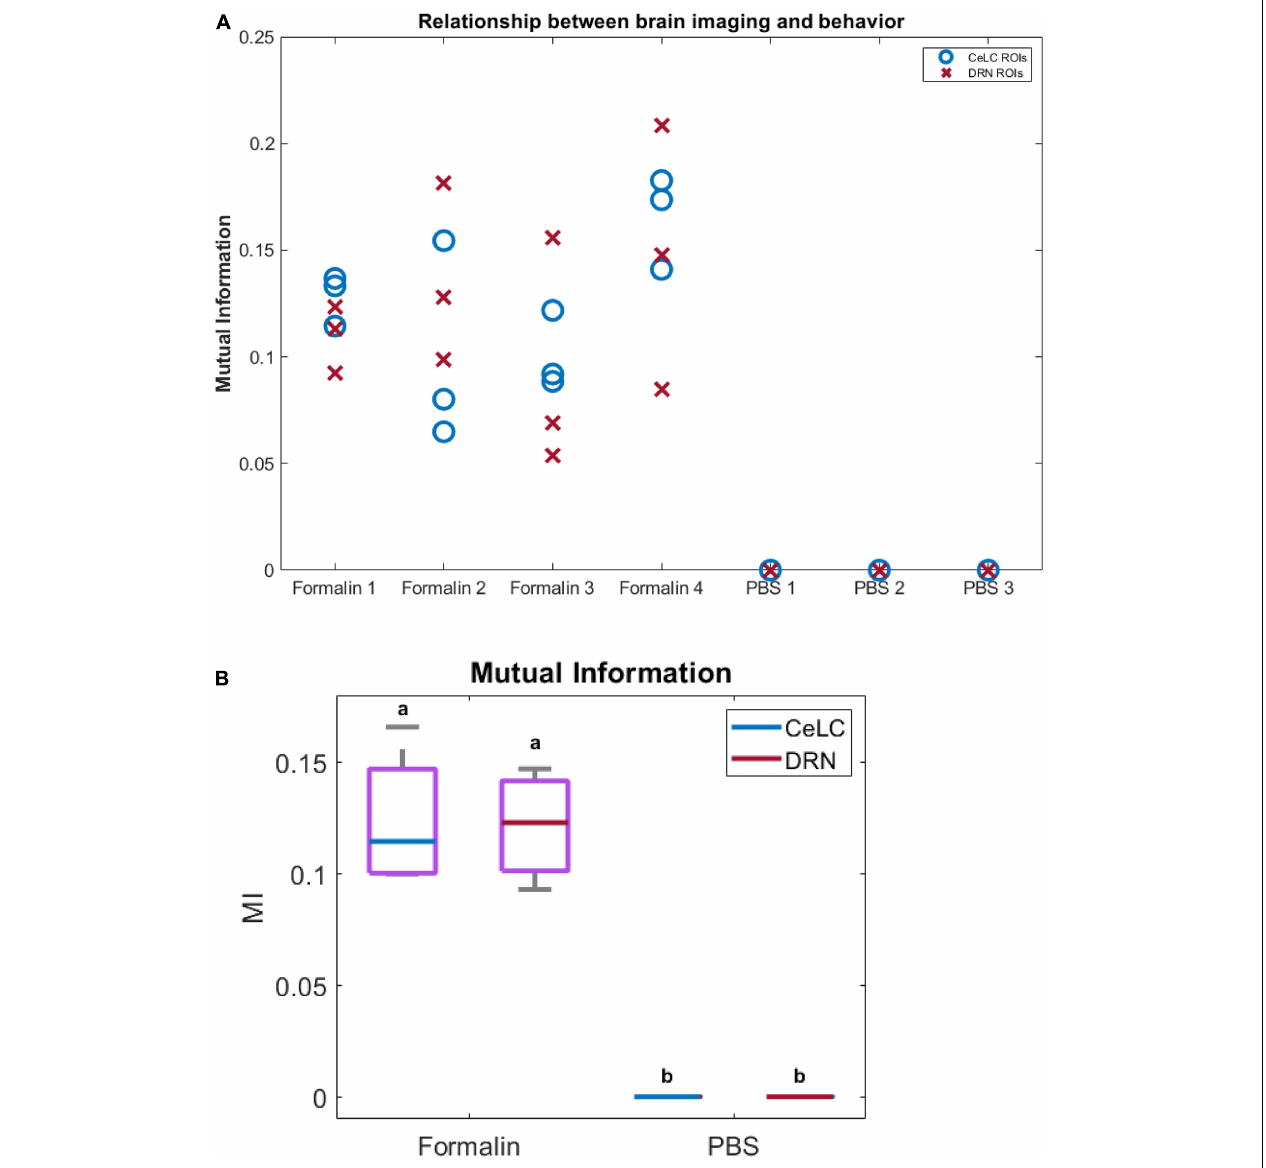
FIGURE 10 | Relationship between brain calcium imaging and licking behavior. Relationship between brain calcium imaging and licking behavior. (A) Plot of mutual information between imaging and behavior. Blue circles indicate ROIs from CeLC, while red crosses indicate ROIs from DRN. (B) Box plot of the mutual information (MI) when ROIs in each mouse were averaged. PBS mice showed almost 0 MI with behavior, while Formalin mice showed higher MI values. Non-parametric two-way ANOVA showed significant difference between Formalin and PBS groups ( p < 0.05, α = 0.05), but no significant difference between CeLC and DRN within each